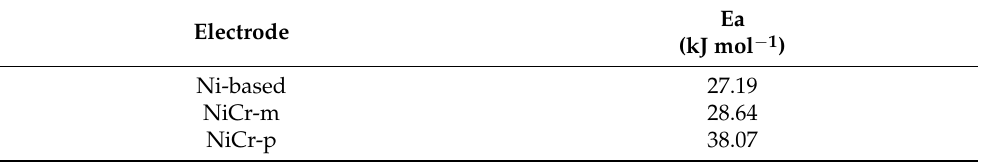
Table 1. Activation energy values are calculated at